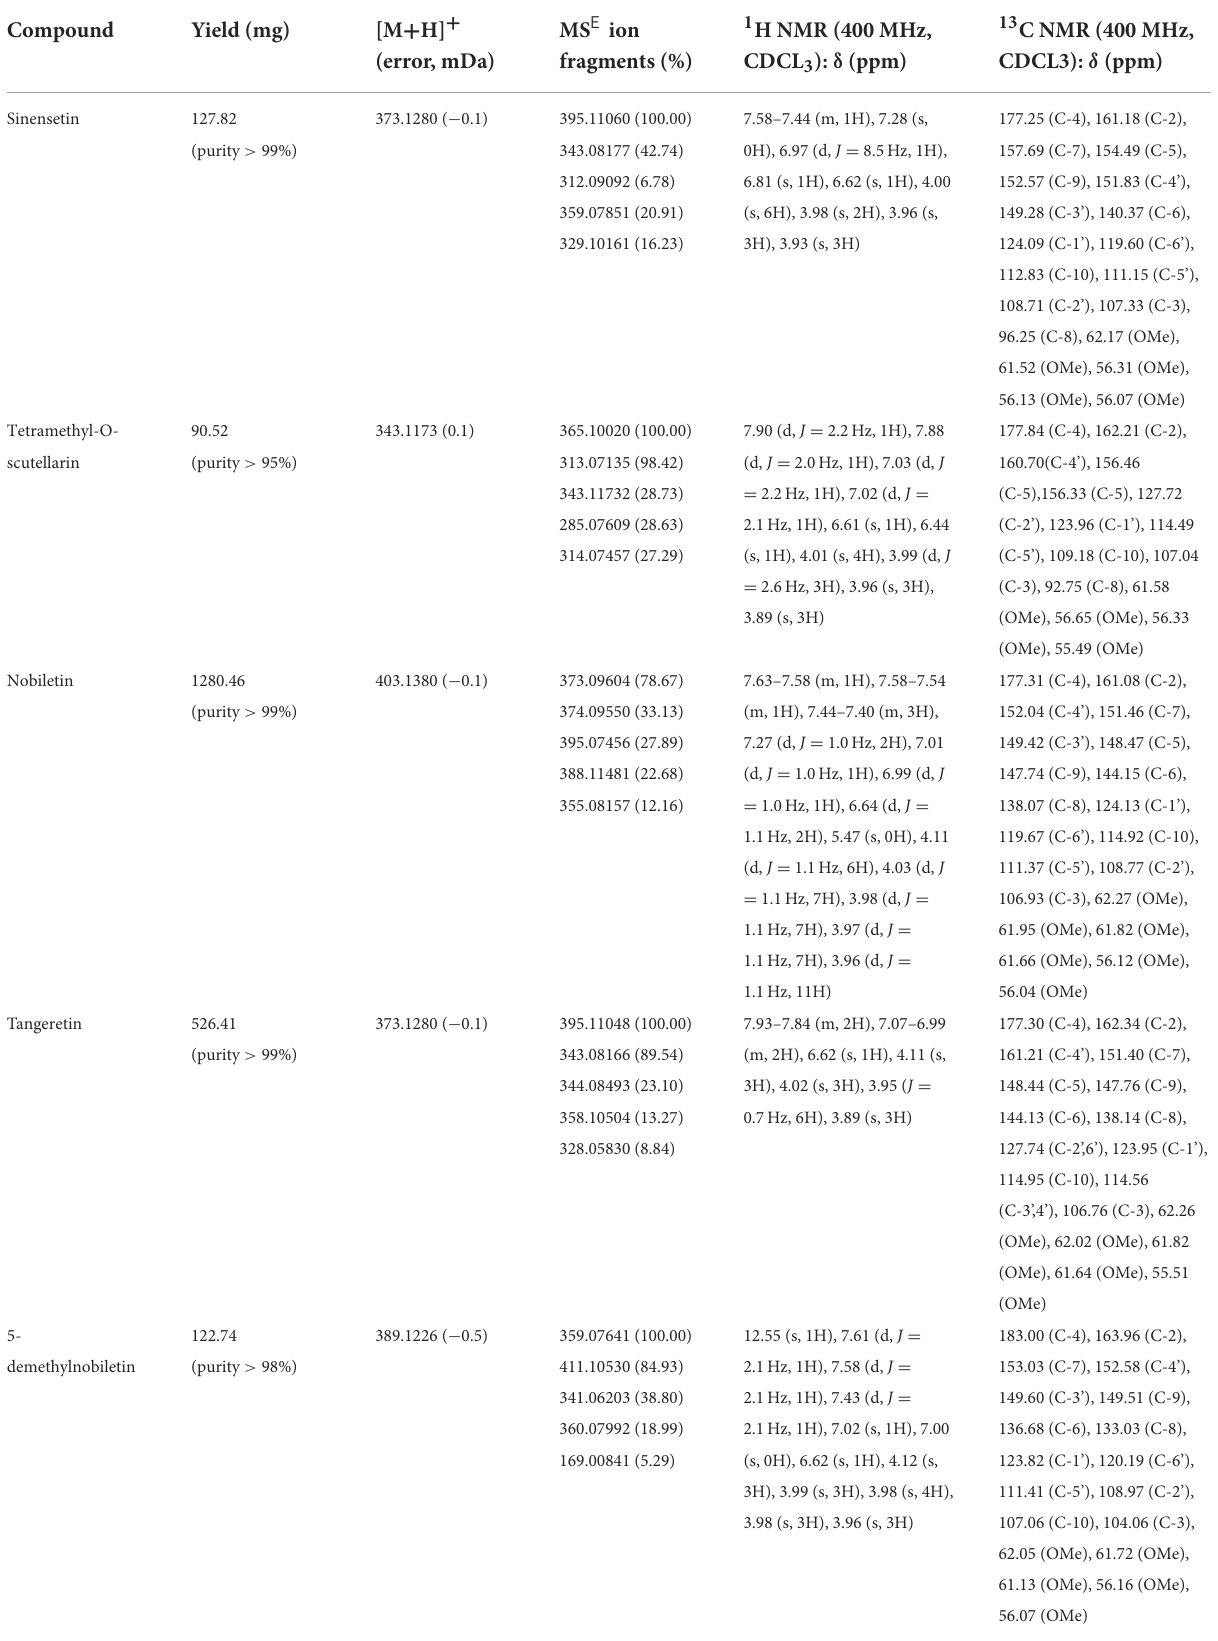
TABLE 1 The yield and spectroscopic data for isolated citrus